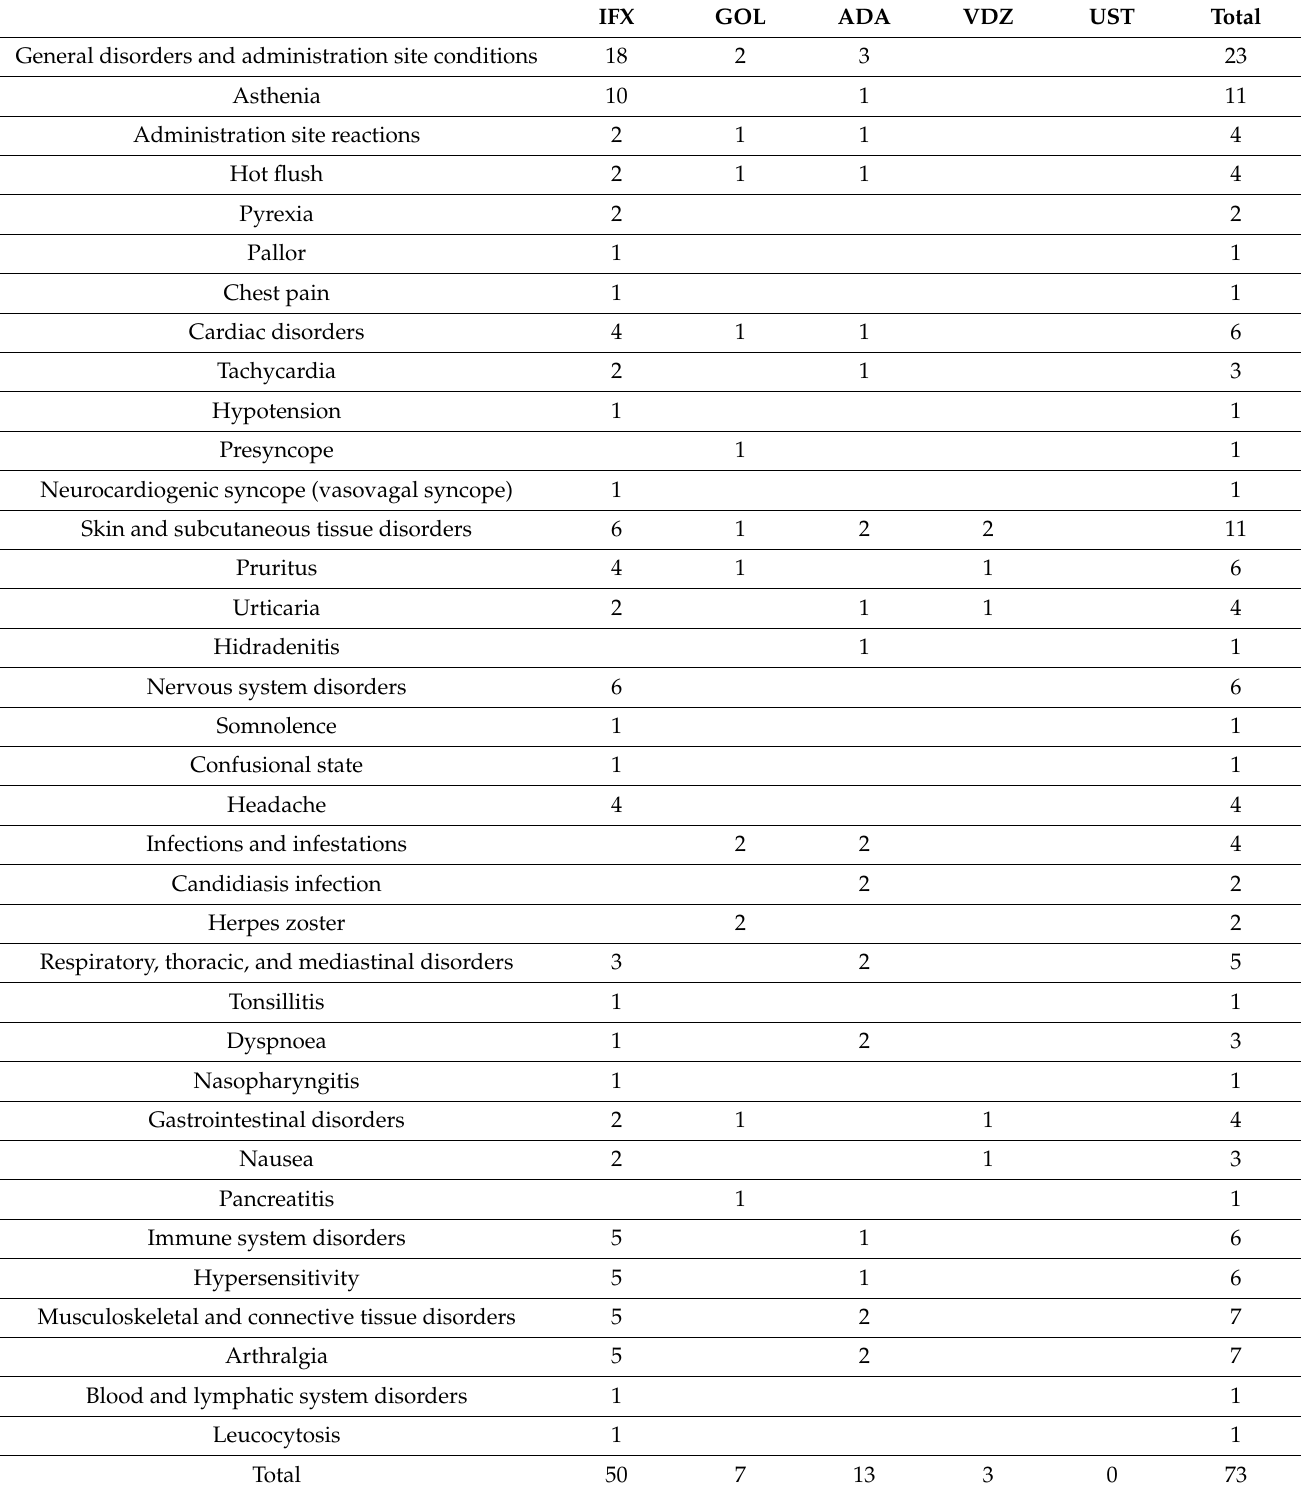
Table 4. SOC-general disorders and administration site